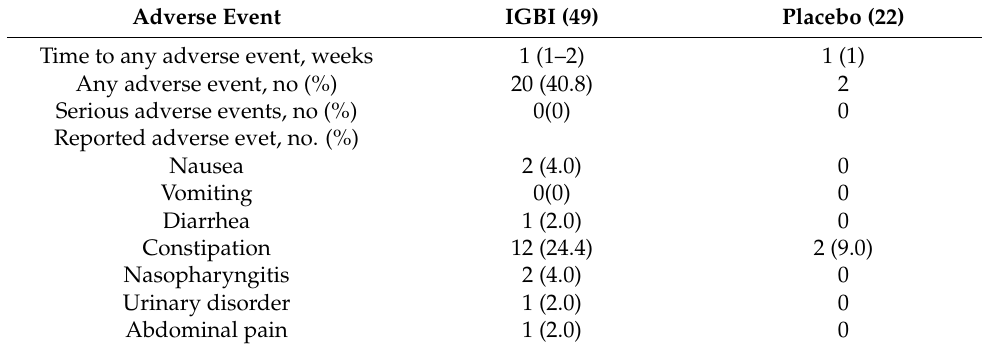
Table 2. Adverse